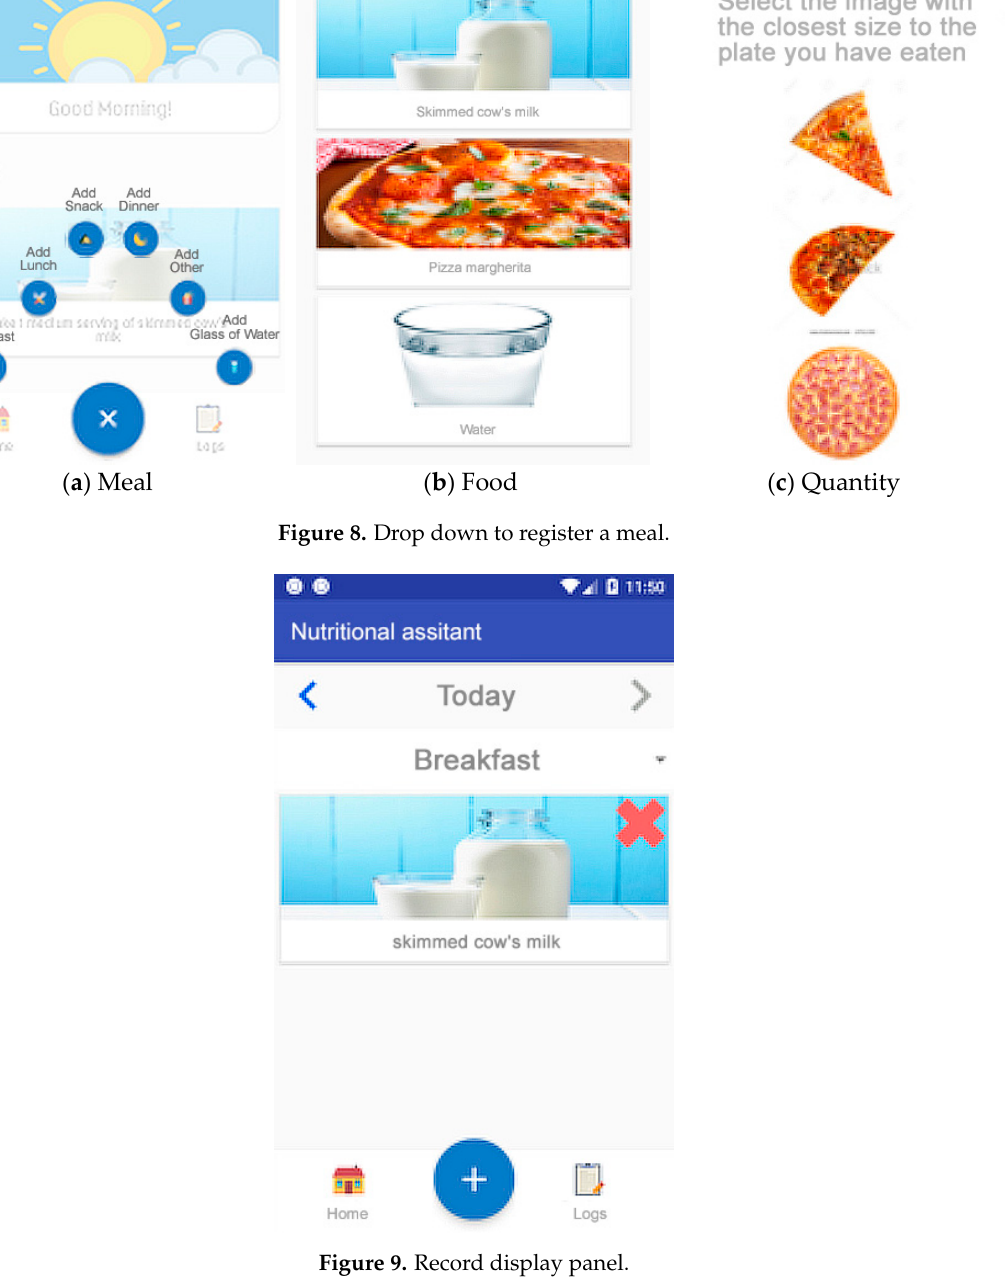
Figure 10. Notification reminder system.